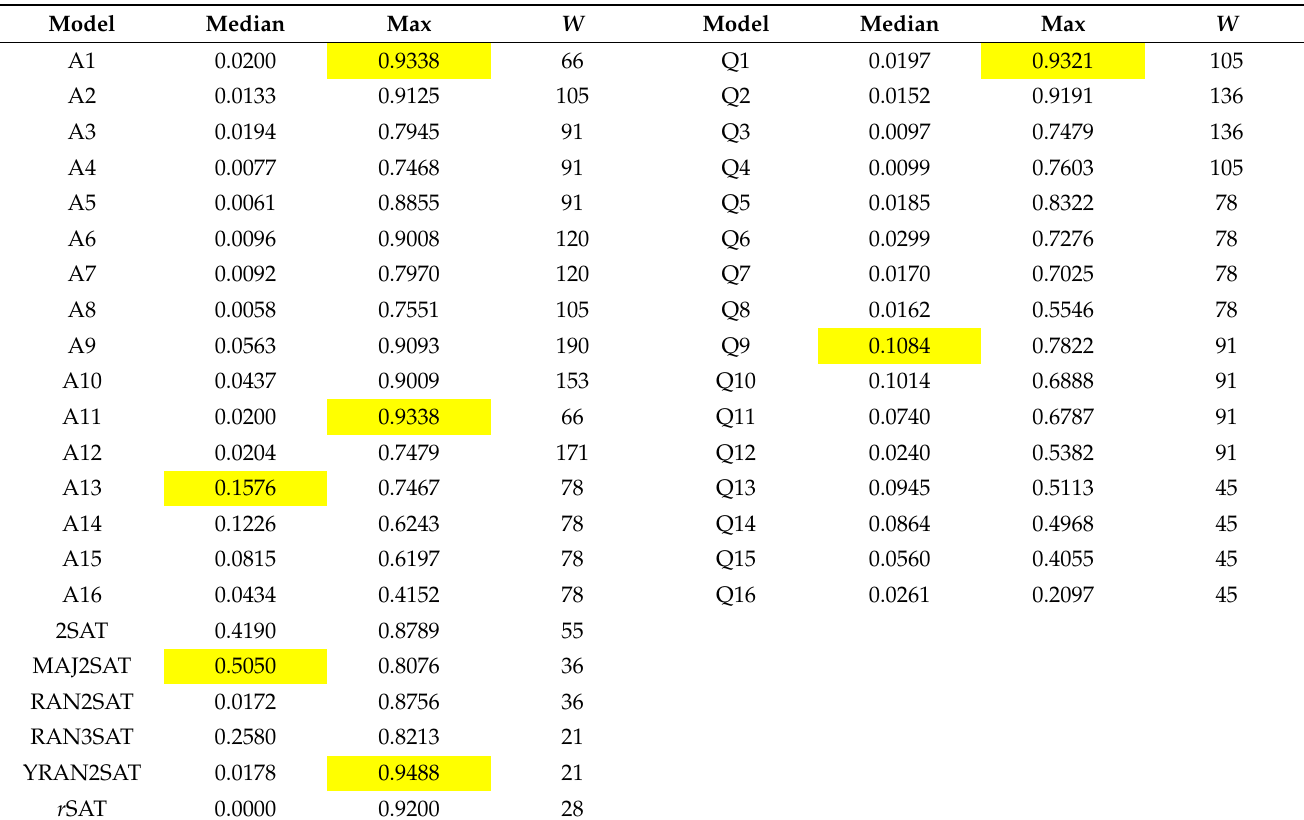
Table 14. Maximum R G results for models in both type of logic δ 1 2 SAT ρ , δ 2 2 SAT ρ and RAN2SAT details by Wilcoxon test for